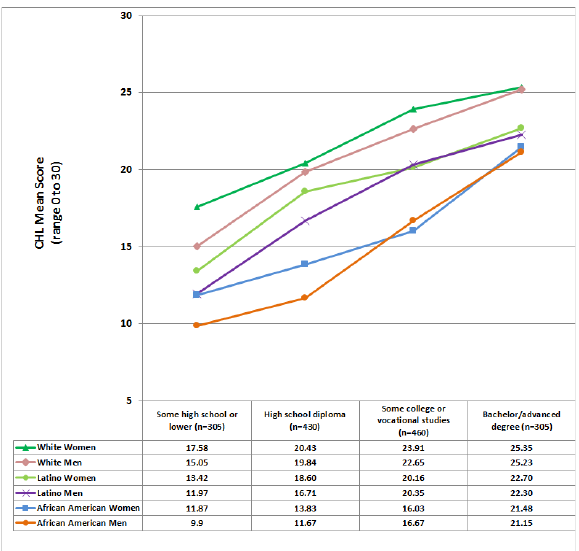
Figure 4. Cancer Health Literacy (CHL) mean scores by race/ethnicity, gender, and education. Note: